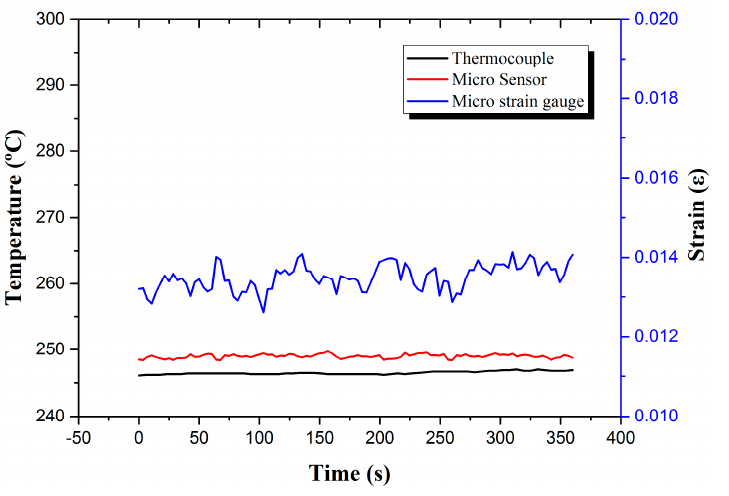
Figure 8. Real-time micro-monitoring of hydrogen charging temperature and strain of hydrogen storage tank.